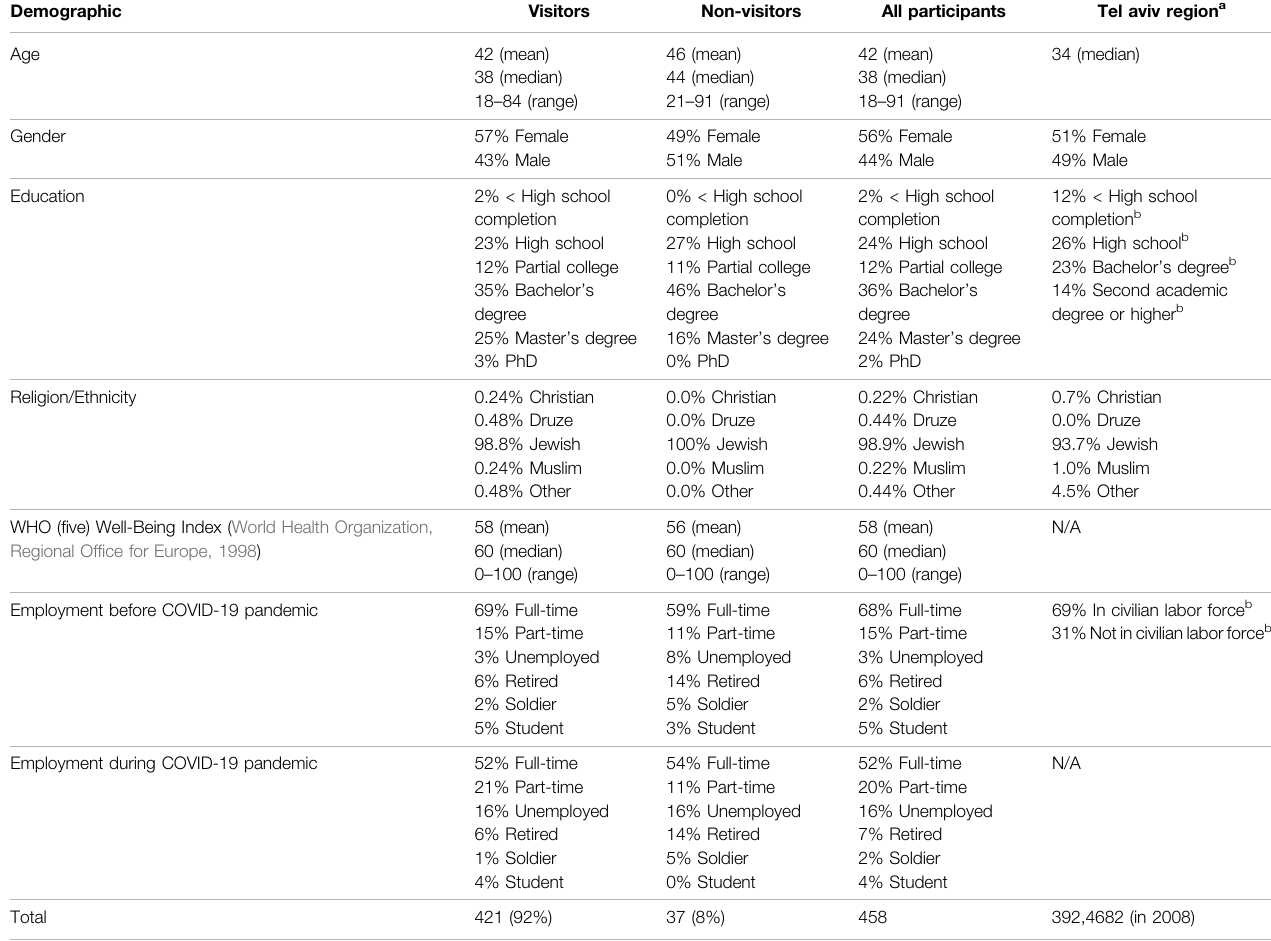
TABLE 4 | Demographics for participant visitors, participant non-visitors, all participants, and the Tel-Aviv Region population. Demographic